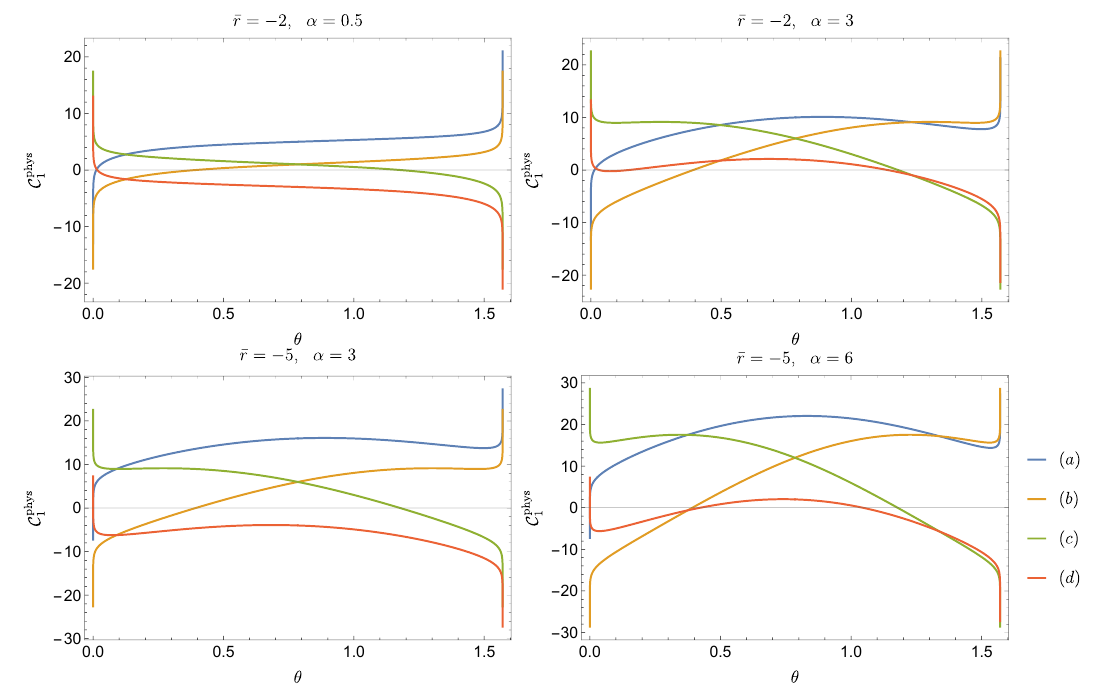
( j 12 i ) in the physical basis as a 1